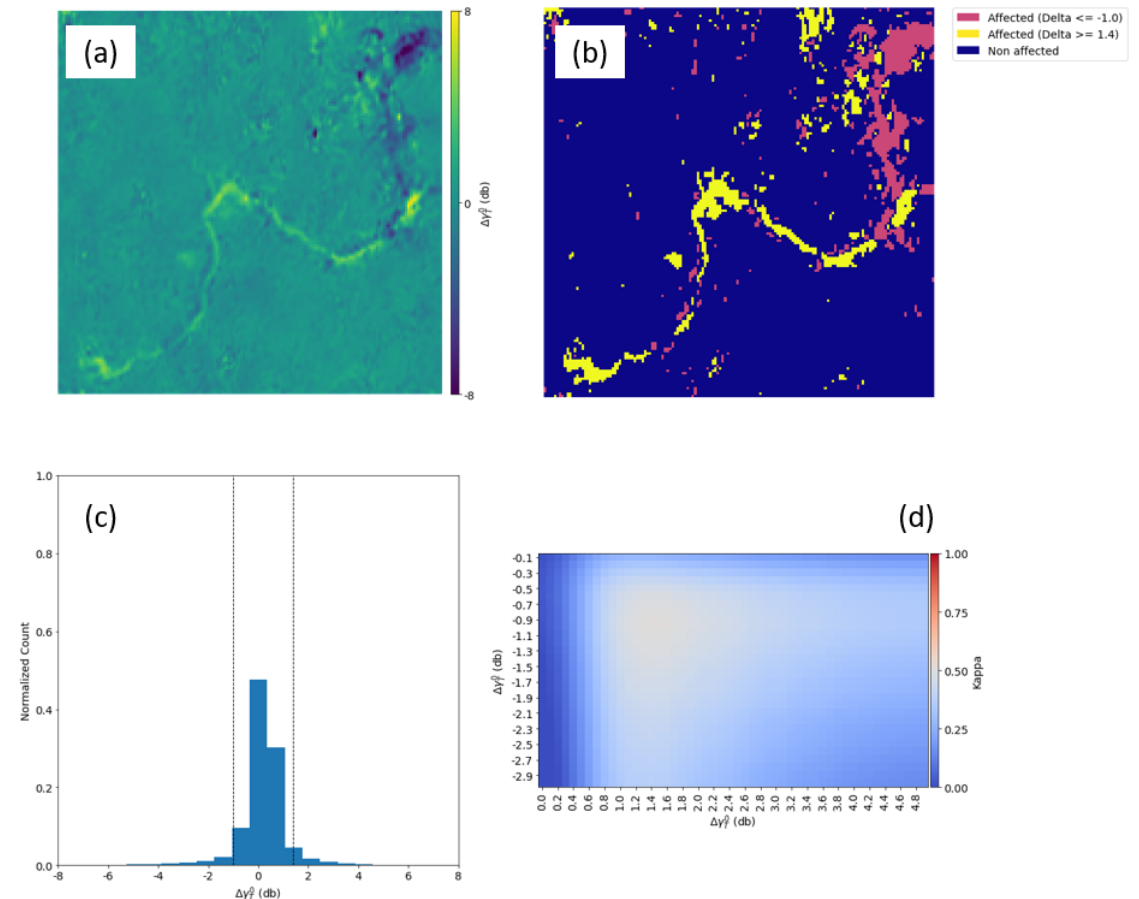
Figure 14. Brumadinho ConvLSTM Delta image of VV polarization ( a ), Flood Proxy Map ( b ), Histogram of Delta image ( c ), and Cohen’s Kappa heatmap ( d ).